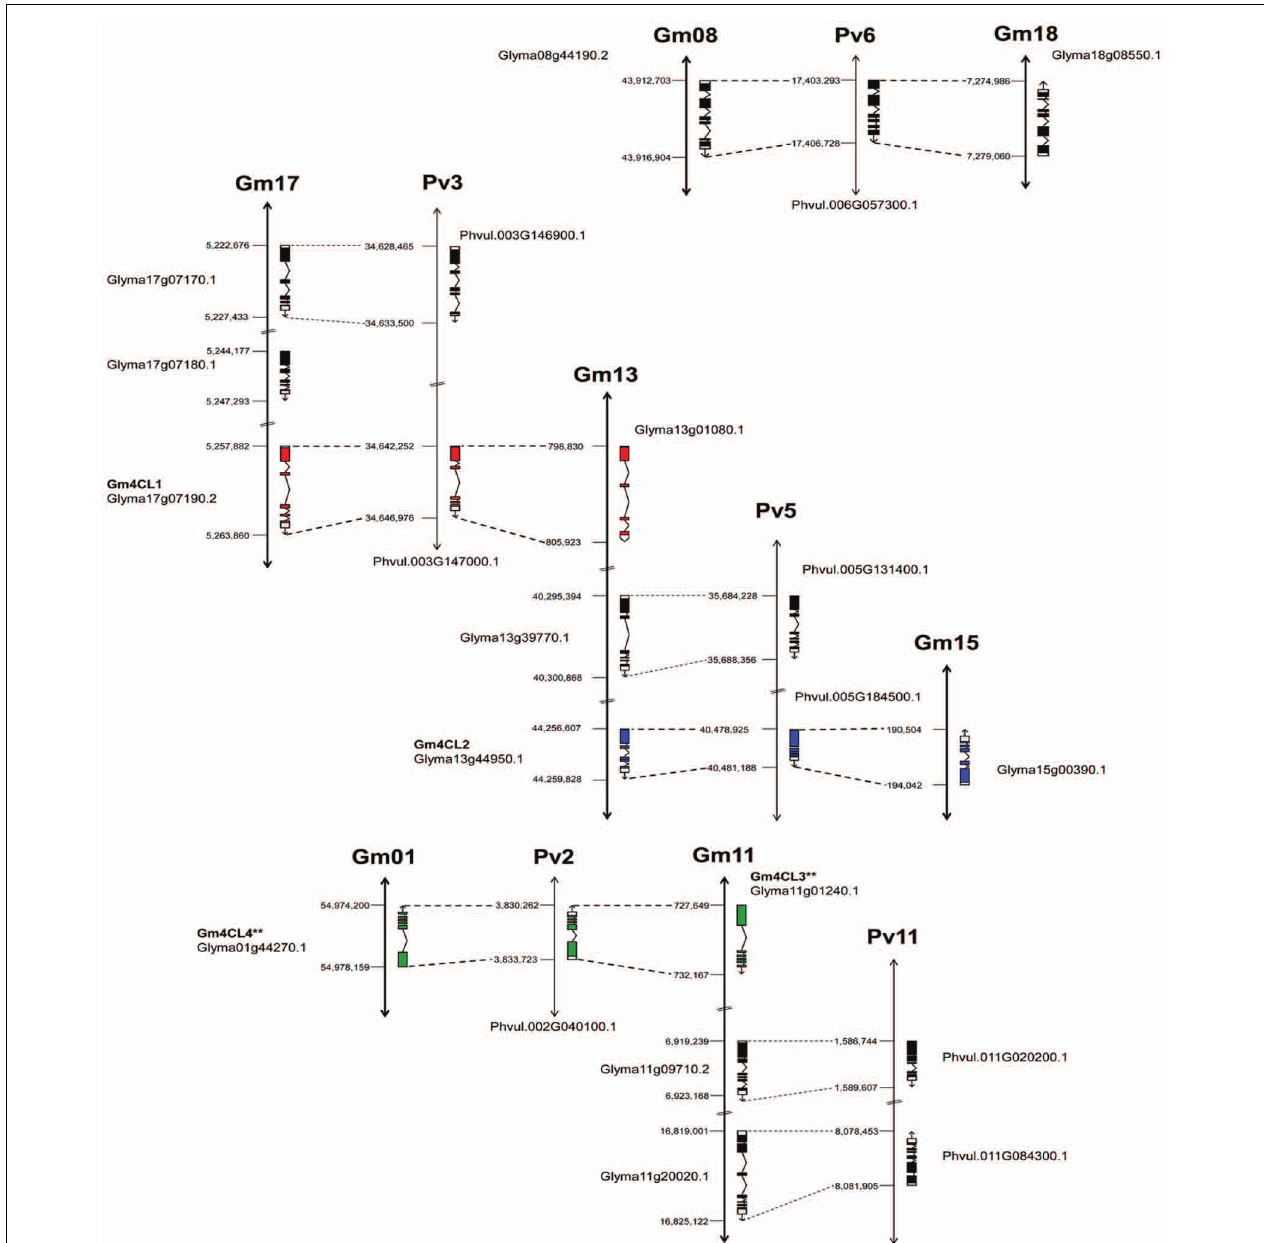
FIGURE 4 | Genome organization of 4CL genes in soybean and common bean. Black bars represent chromosomes. Exon/intron structure of 4CL genes (Phytozome) is indicated. Exons are represented as filled boxes and introns are shown as lines between